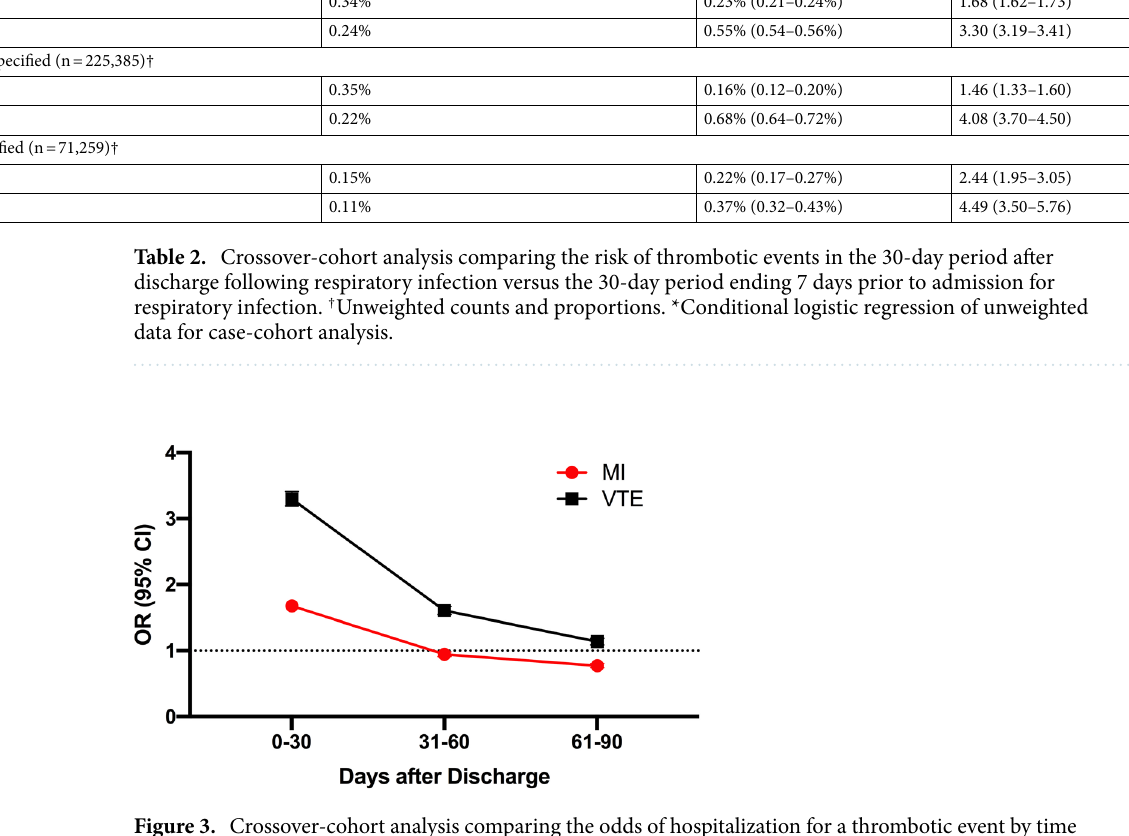
Figure 3. Crossover-cohort analysis comparing the odds of hospitalization for a thrombotic event by time period after respiratory infection versus a 30-day baseline period prior to